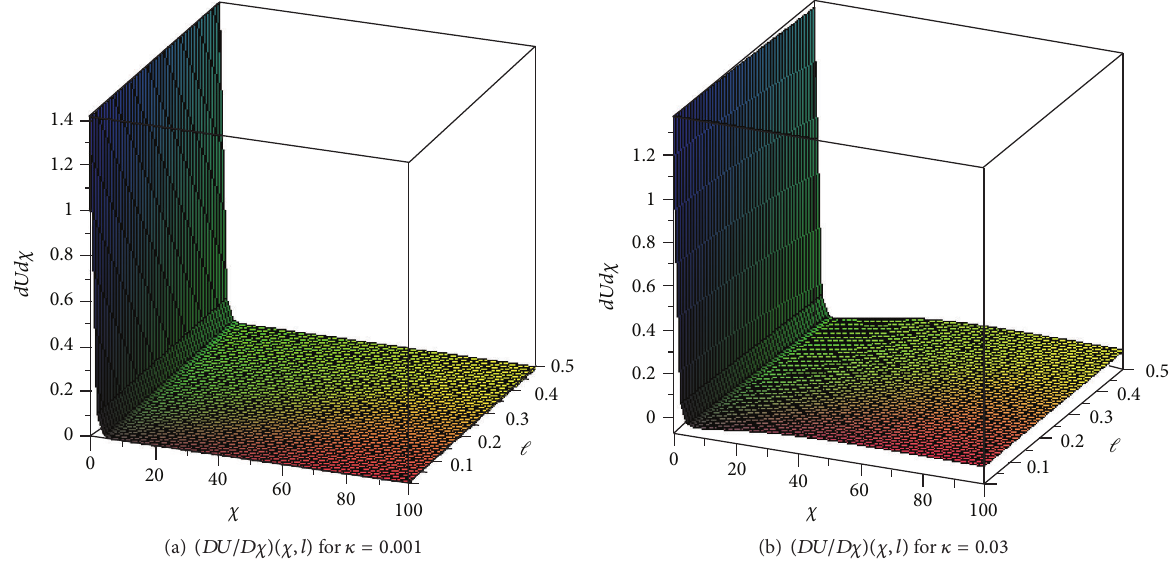
Figure 8: 3D plot of (𝐷𝑈/𝐷𝜒)(𝜒,𝑙) for two 𝜅 values: (a) 𝜅 = 0.001 and (b) 𝜅 = 0.03